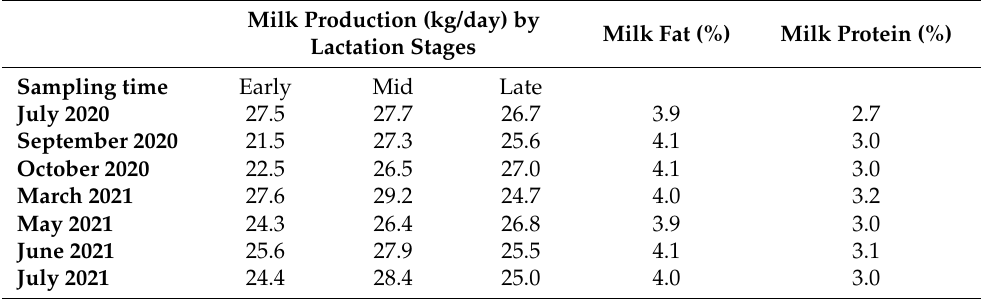
Table 1. Average milk production across lactation stages and sampling times and milk quality results across different sampling times.